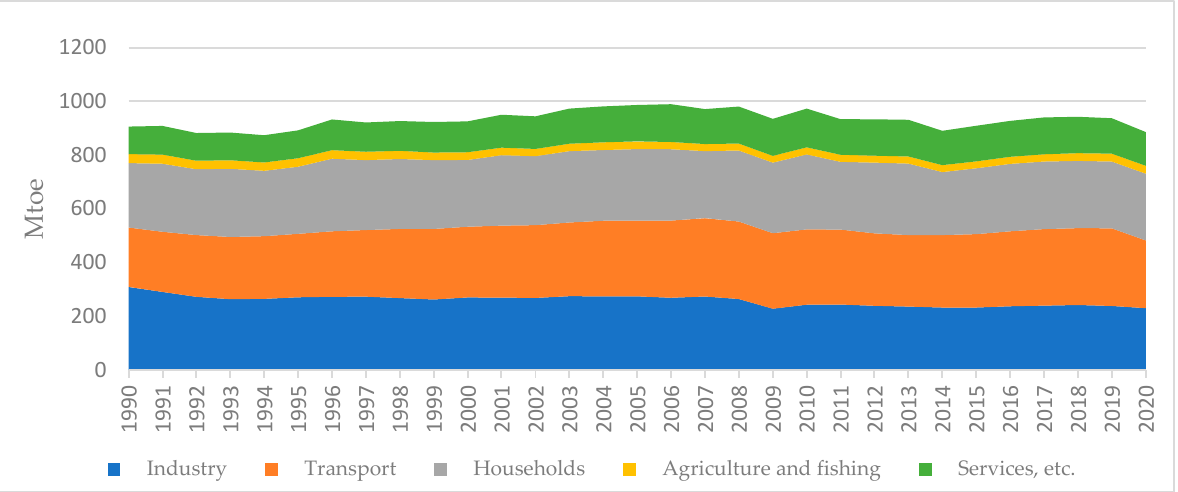
Figure 2. ( A ) Final energy consumption by sector in EU-27 in 1990 (shares of total consumption in EU). ( B ) Final energy consumption by sector in EU-27 in 2020 (shares of total consumption in the EU). Source: Own elaboration based on Eurostat 2022; European Environment Agency 2022.